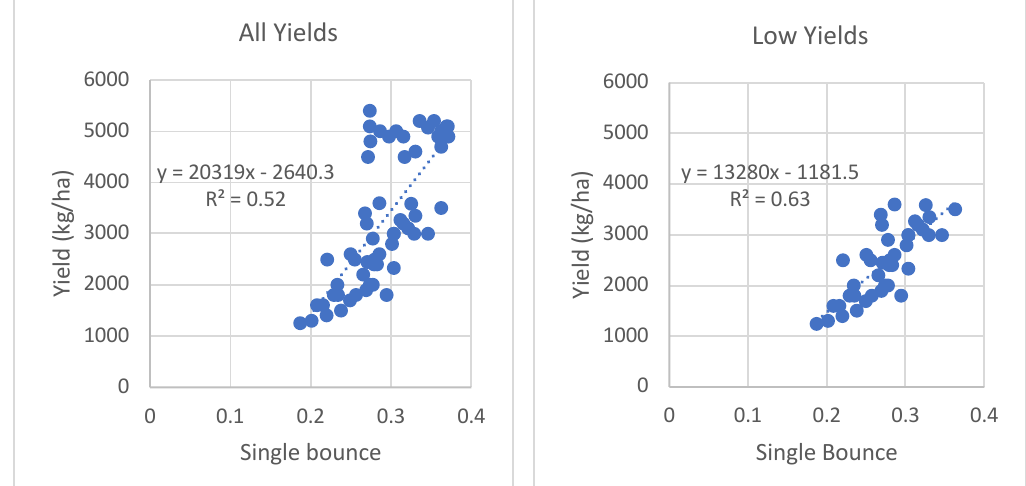
Figure 3. Correlation between single-bounce and soybean yield for (a) all yield values and (b) only low yield values.